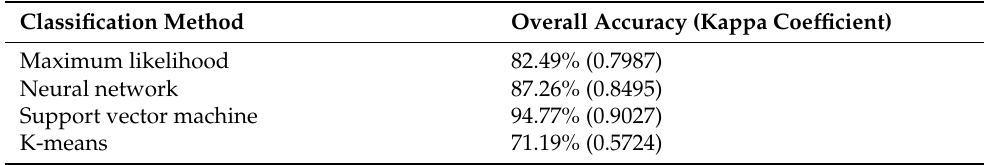
Table 1. Classification accuracy of land cover types with different models.